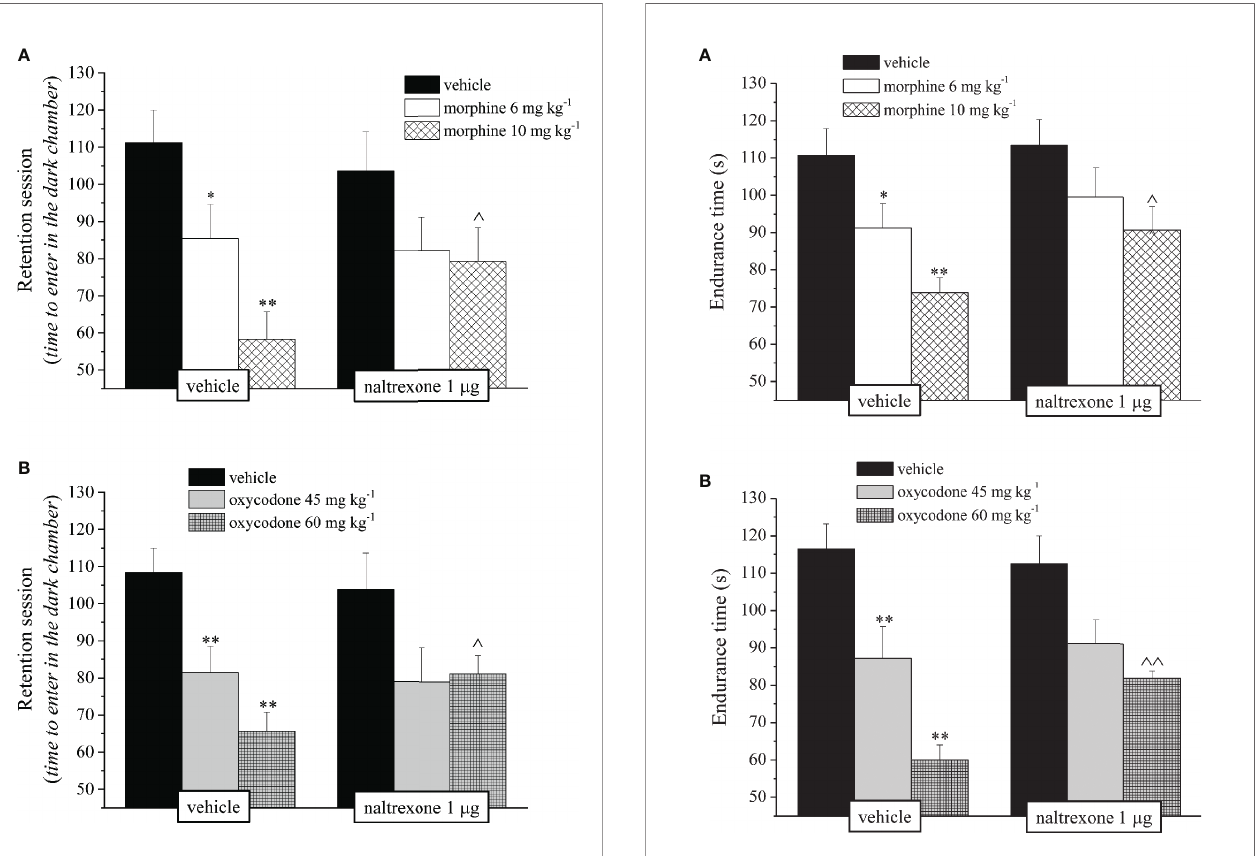
FIGURE 3 | Effect of intranasal administration of naltrexone on morphine and oxycodone induced motor incoordination in the mouse. Motor impairment was evaluated by the Rota rod test. Naltrexone 1 m g was intranasally administered 30 min before the intraperitoneal injection of (A) morphine (6 and 10 mg kg − 1 ) or (B) oxycodone (45 and 60 mg kg − 1 ). Behavioral measurements were performed 30 min after opioid treatment. Control animals were treated with vehicles. Each value represents the mean of 10 mice per group, performed in two different experimental sets. *P < 0.05 and **P < 0.01 vs vehicle-treated animals; ^P < 0.05 and ^^P < 0.0 vs morphine or oxycodone-treated